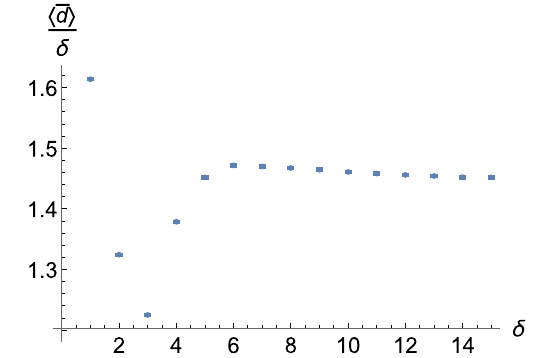
Fig. 3 Normalized average sphere distance (cid:2) ¯ d (cid:3) /δ as a function of δ , measured at volume N 41 = 480 k and using the link distance (error bars too small to be